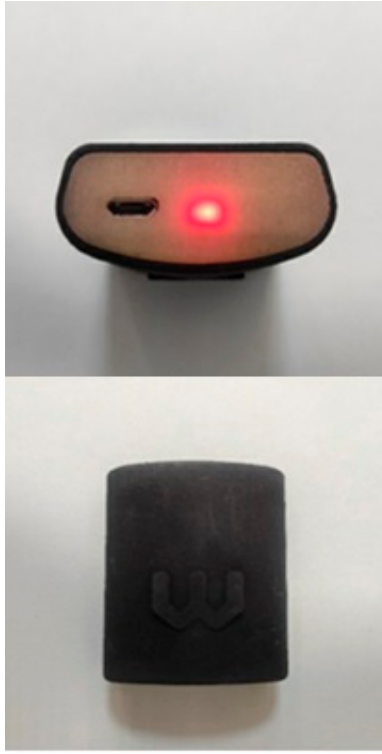
Figure 1. Wiva Science IMU. (Inertial Measurement